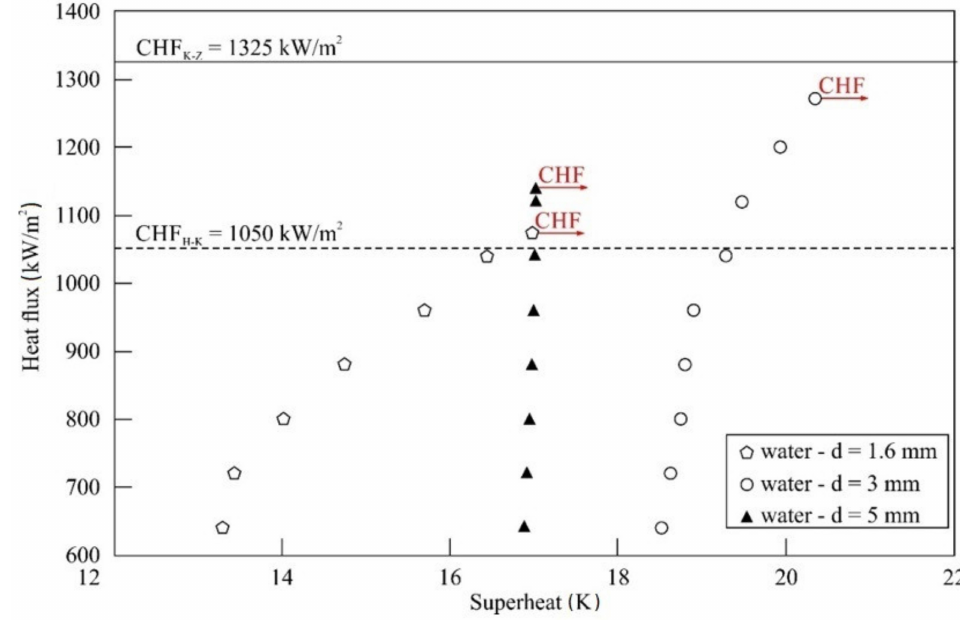
Figure 7. Boiling curves and CHF for deionized water on stainless steel